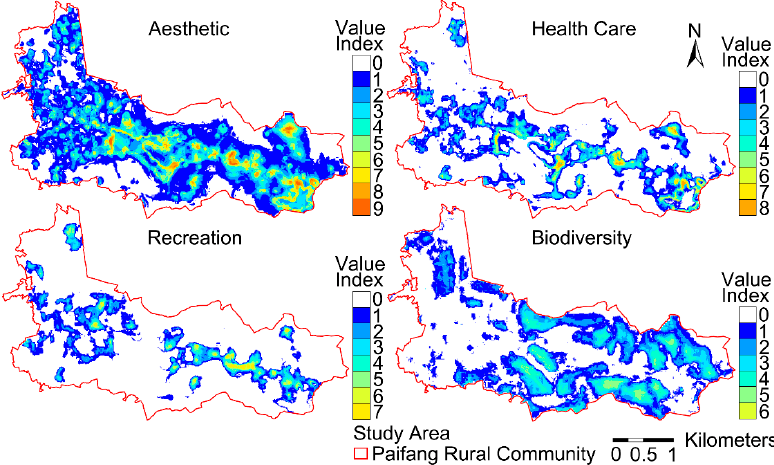
Figure 6. Spatial distribution of four social value types in the Paifang rural community.